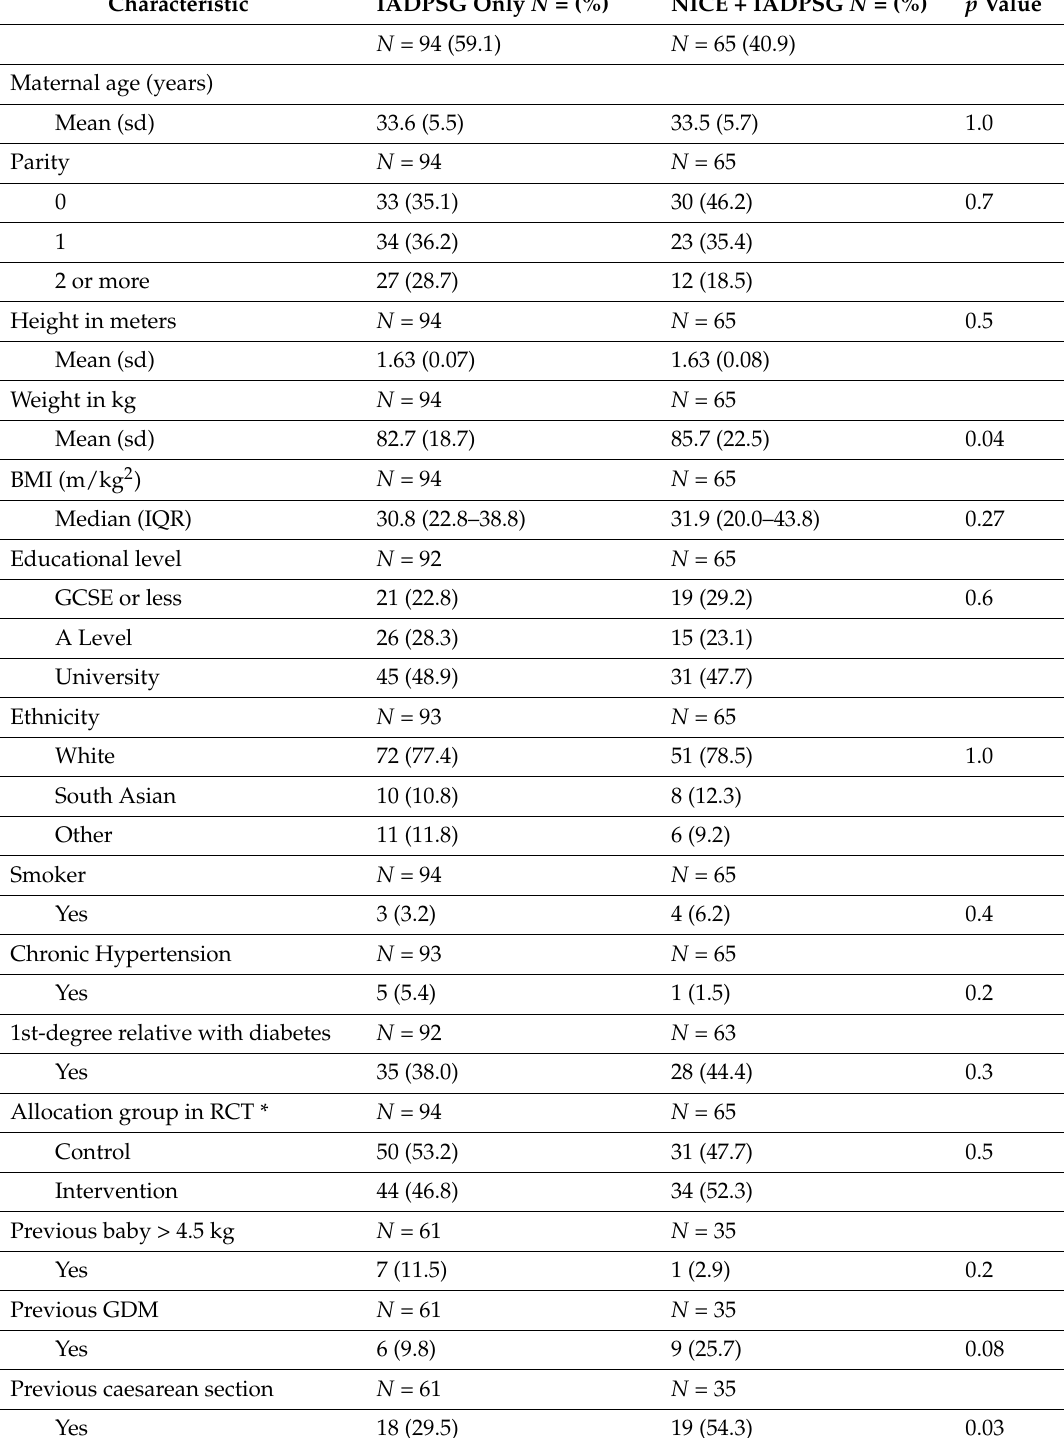
Table 1. Baseline characteristics of participants according to group, N =